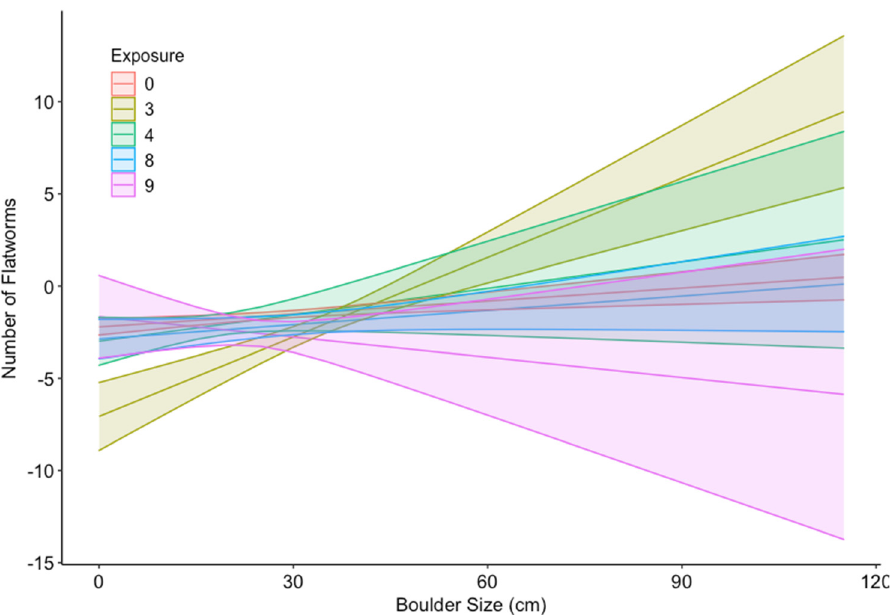
Figure 6. Interaction plot comparing the estimated marginal means of flatworms across boulder sizes and different levels of exposure (0 being a more protected beach and 9 being more exposed). Non-parallel lines indicate an interaction between factors. Ribbons represent 95% confidence interval limits.